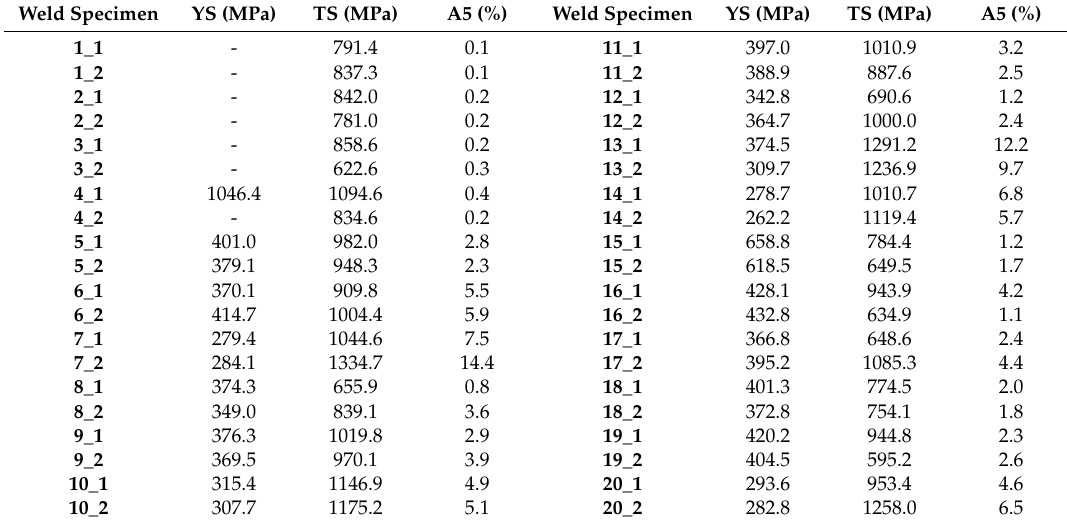
Weld Specimen YS (MPa) TS (MPa) A5 (%) 1_1 -